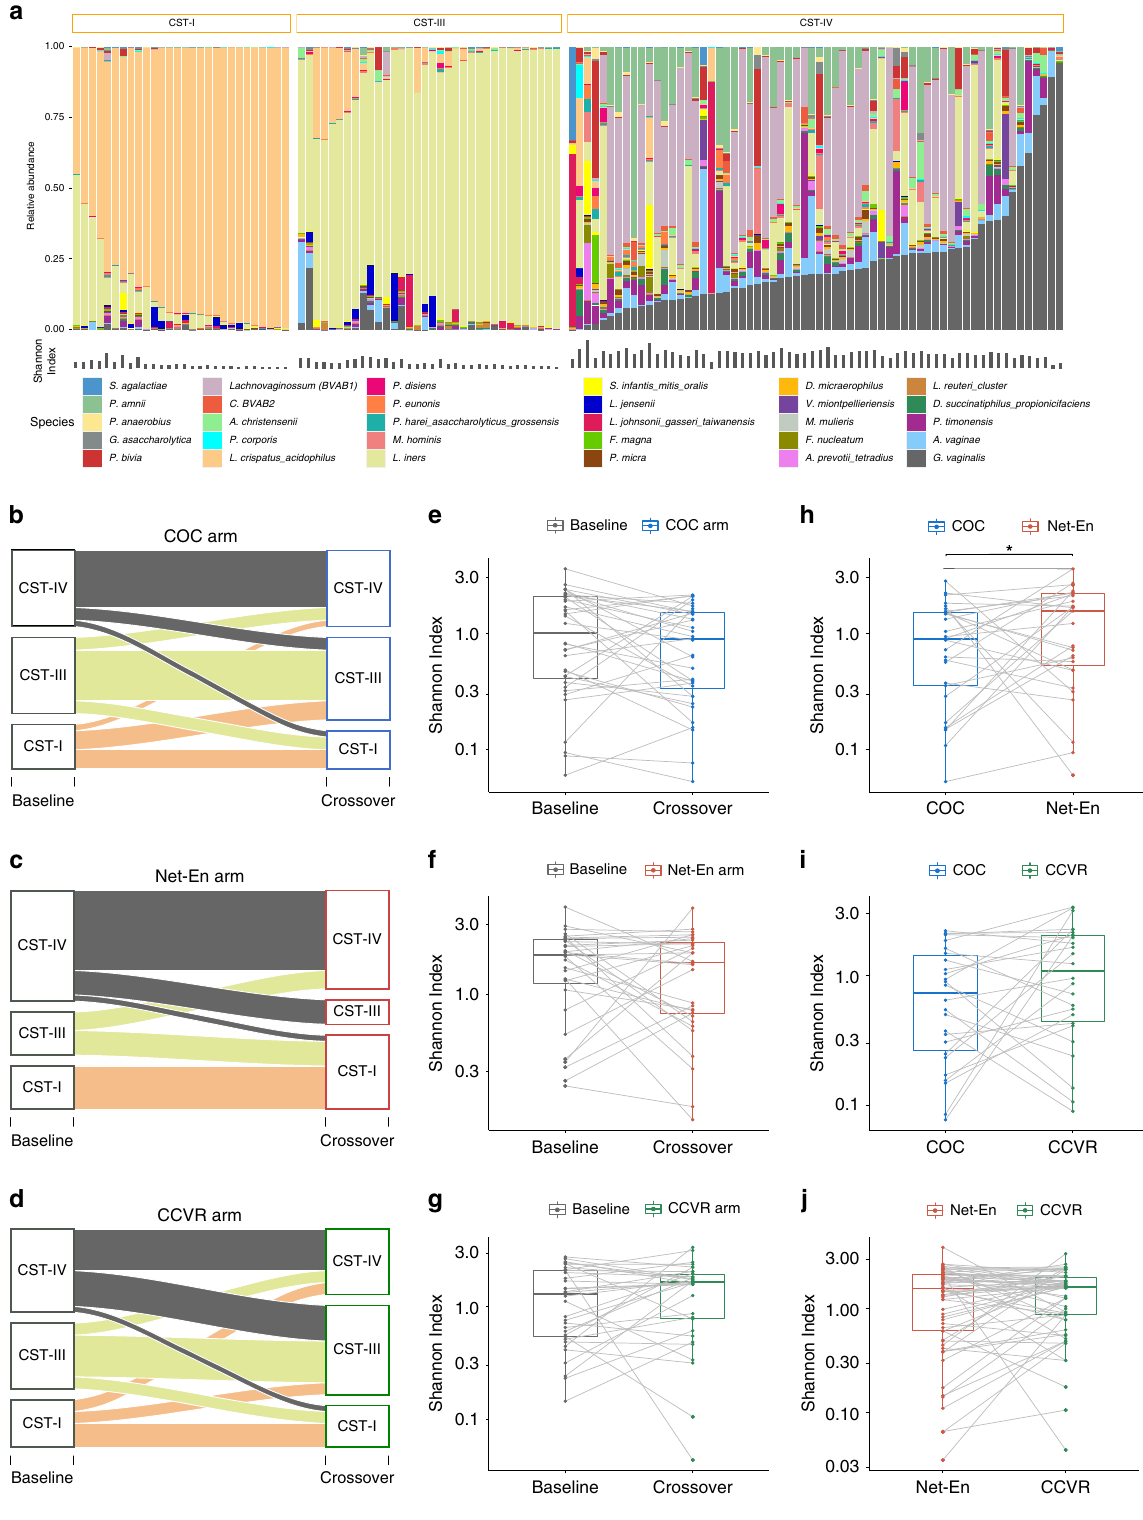
time since the last menstrual period in the COC versus CCVR arm to 0.0371 in the Net-En versus CCVR arm (Supplementary Table 2). To assess differences in community composition cross- sectionally, we performed a permutational multivariate analysis of variance (PERMANOVA) on phylogenetic distances at cross- over. We found signi fi cant differences in beta diversity between